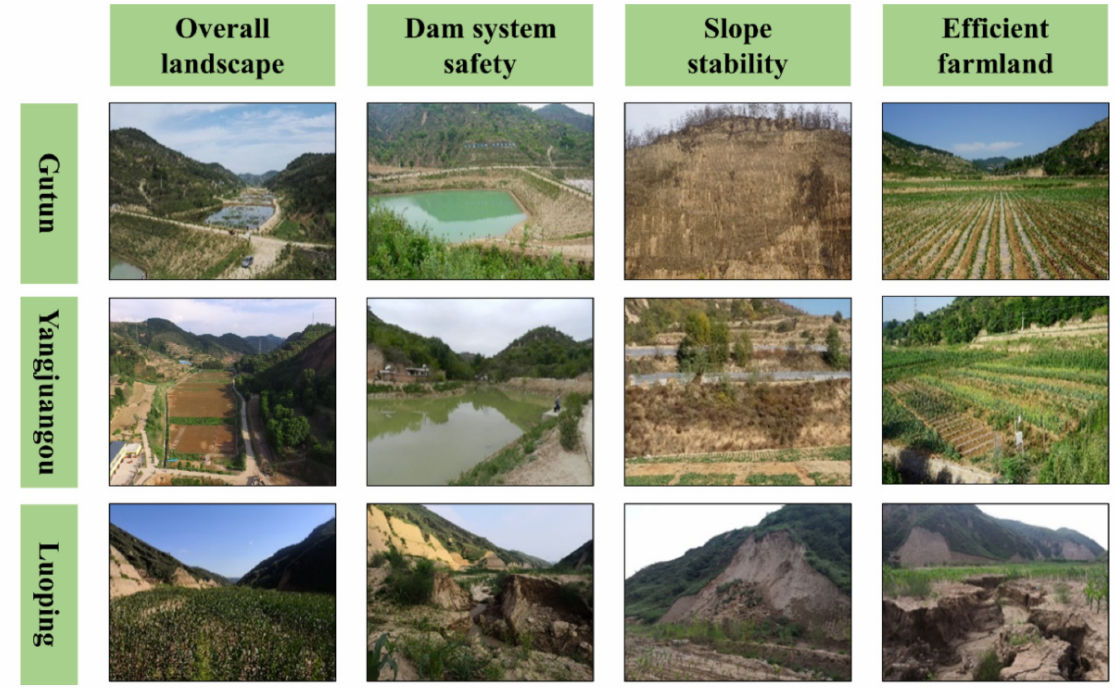
Figure 5. Differentiation analysis of the ecological safety effects in different GLCP